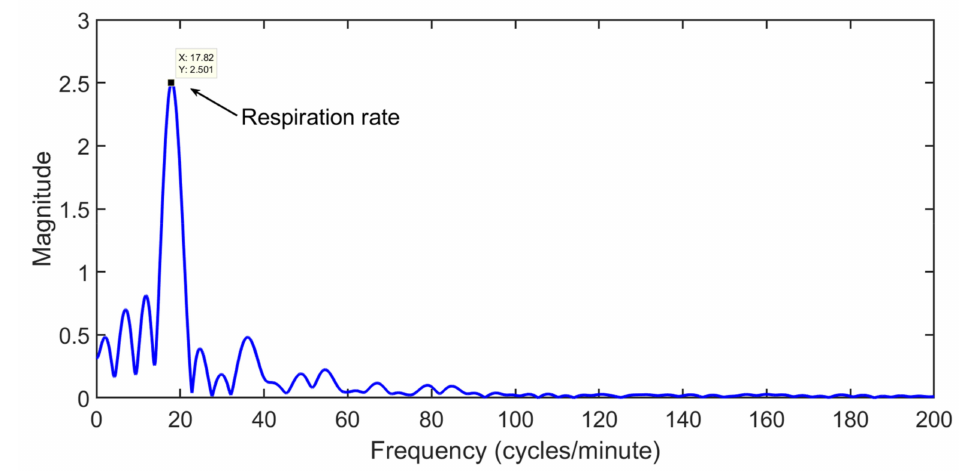
Figure 6. The frequency transformed version of the vital